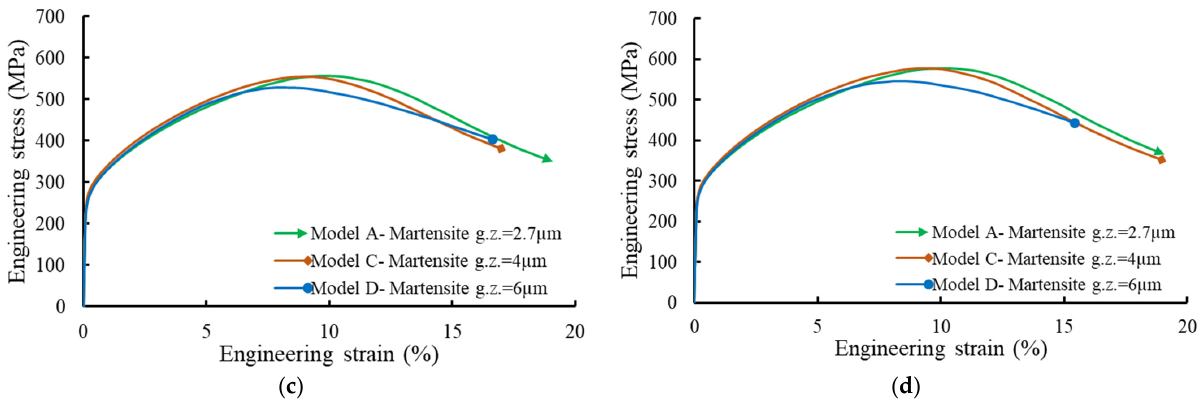
Figure 7. Comparison of stress–strain curves of martensite grain sizes in ( a ) uniaxial tension, ( b ) plane strain tension, ( c ) partial biaxial tension, and ( d ) equi-biaxial loading. By increasing martensite grain sizes, the limiting major and minor strains decreased in the case of the M-K approach with some exceptions in uniaxial loading cases, as shown in FLDs in Figure 8. On the other hand, in the case of the K-B approach, the variation in martensite grain sizes did not have a remarkable effect on formability.